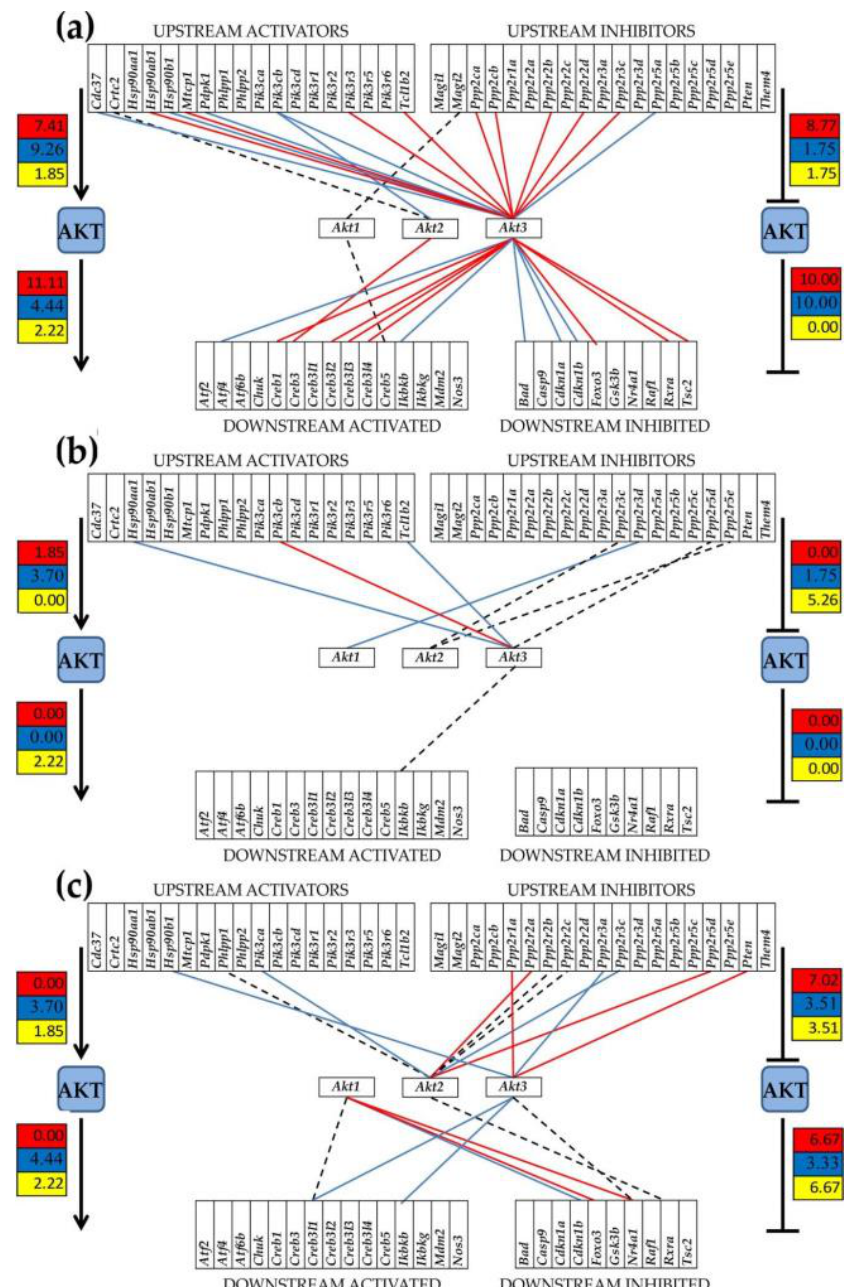
Figure 7. Statistically significant expression correlation of the AKT block of genes ( Akt1, Akt2, Akt3 ) with KEGG software identified upstream and downstream genes in ( a ) MRL/+, ( b ) MRL/ lpr , ( c ) Fn14ko mouse cortices. Red/blue/black lines indicate synergistic/antagonistic/independent expression of the linked genes. Missing gene interlinks mean that the expression correlation was not statistically significant. Numbers on the icons indicate percentage of: statistically significant ( p < 0.05) synergistically (red background), antagonistically (blue background), or independently (yellow background) expressed gene pairs in the corresponding group of AKT partners.